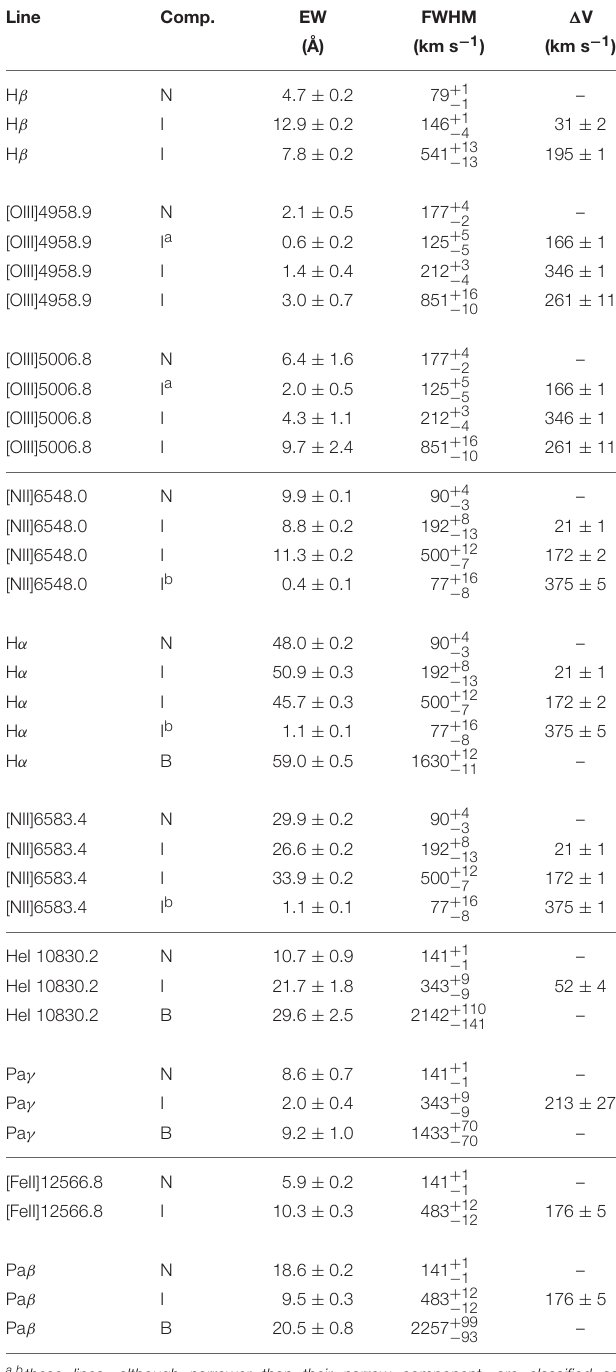
TABLE 1 | Emission line fitting